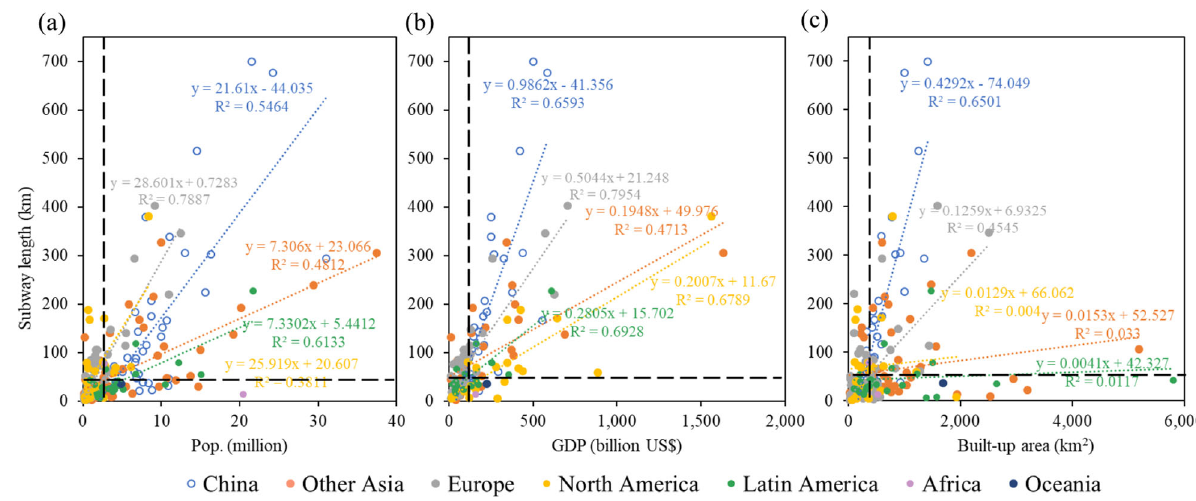
Fig. 2 Correlations between subway length and urban socioeconomic parameters for all world regions. ( a ) population, ( b ) GDP, and ( c ) built-up area. The results are presented in four quadrants based on median values (as dashed lines) of subway length, population, GDP, and built-up area for all cities. The regression trend lines of Africa and Oceania are not added because they only have a small number of cities with